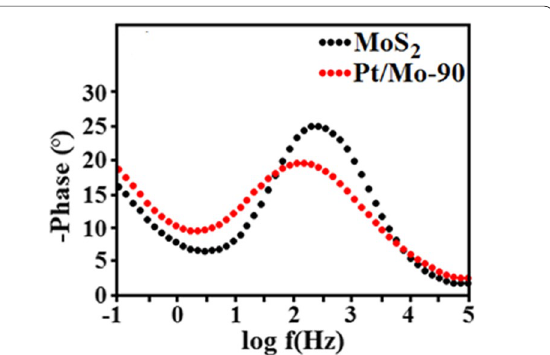
Fig. 8 Nyquist plots of bare GCE, Pure MoS 2 nanosheets, Pt/Mo-60, Pt/Mo-90, and Pt/Mo-120-modified GCE in 0.5 M H 2 SO 4 solution; inset: the equivalent circuit